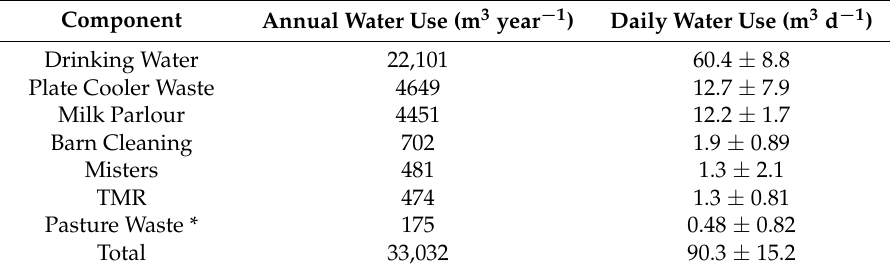
Table 2. Allocation of total on-farm water uses.